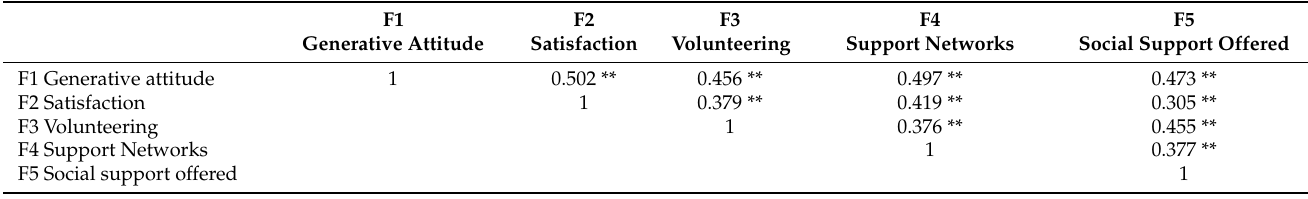
Table 3. Correlation of the factors of the generativity scale ( n = 450).